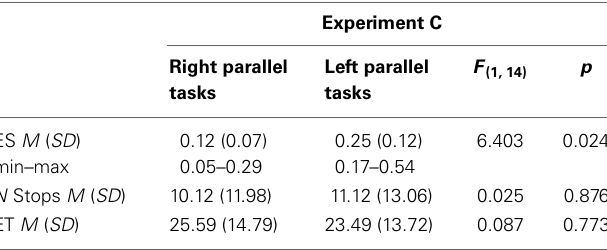
Table 2 | Descriptive data for Experiment C (Angle Paradigm).